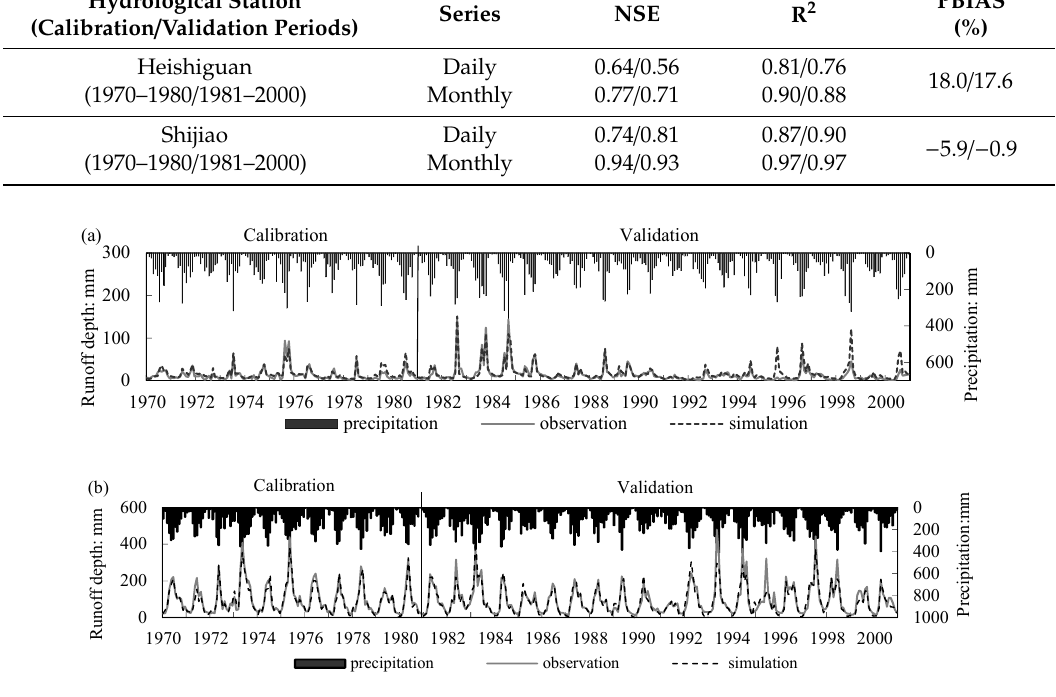
Figure 2. Monthly precipitation and observed / simulated runoff at ( a ) Heishiguan station on the Yiluo River and ( b ) Shijiao station on the Beijiang River for periods of calibration (1970–1980) and validation (1981–2000).